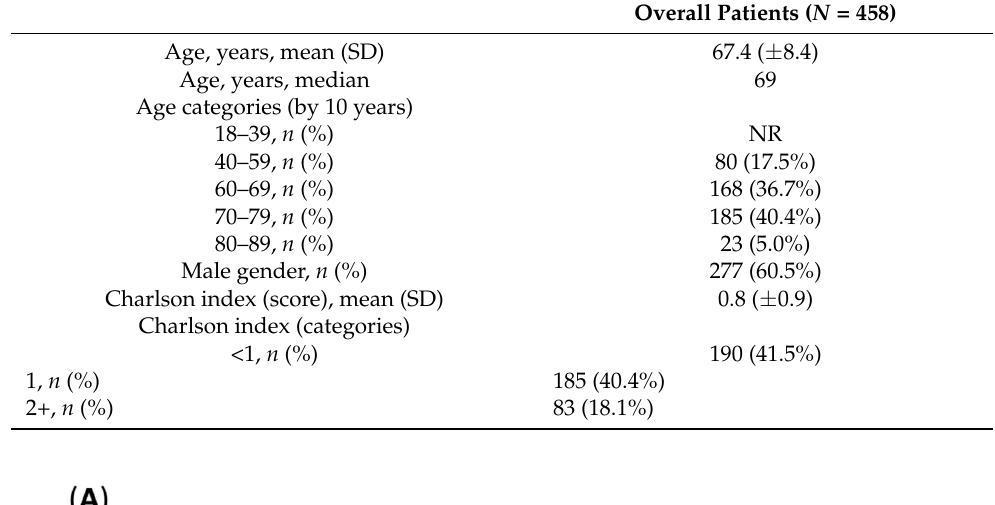
Table 1. Demographic and clinical characteristics of eNSCLC patients who had chemotherapy after surgery in stage II–III (study period January 2015–June 2021).